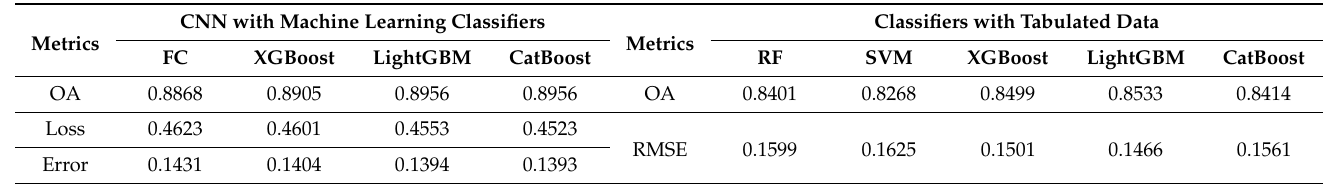
Table 4. Statistical indicators of CNN-based and benchmark methods. FC: Fully connected